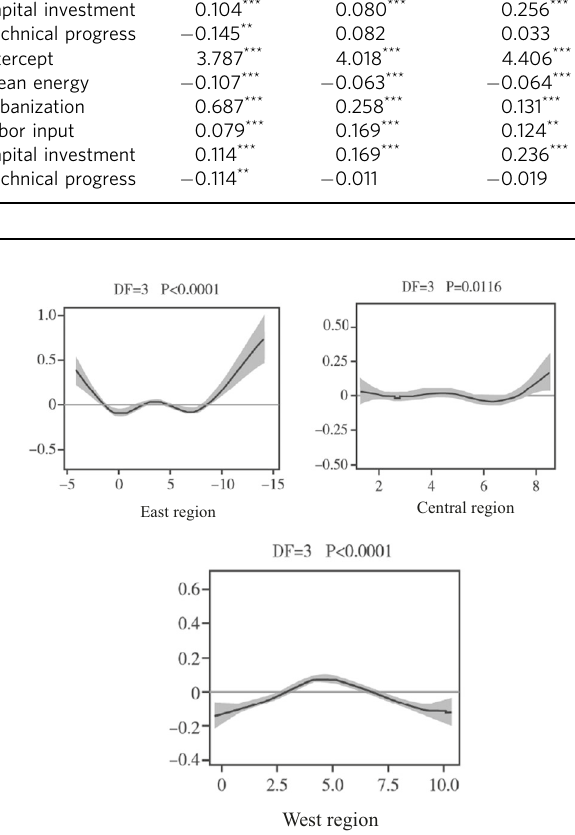
Fig. 1 The nonlinear effect of CED on China ’ s regional economic growth. The nonlinear impact of CED on economic growth shows a “ W-shaped ” curve in the eastern region. The nonlinear impact of CED on economic growth shows a gentle “ W-shape ” curve in the central region. The nonlinear effect of CED on economic growth shows an inverse “ U-shaped ” curve in the